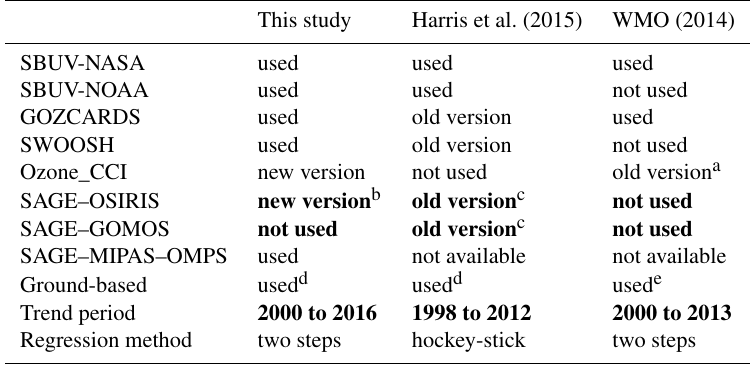
Table 3. Comparison between principal data sets, trend periods, and regression method used in the present study, in Harris et al. (2015), and in WMO (2014). Here only major changes in data sets are indicated. Boldface indicates the most relevant differences. This